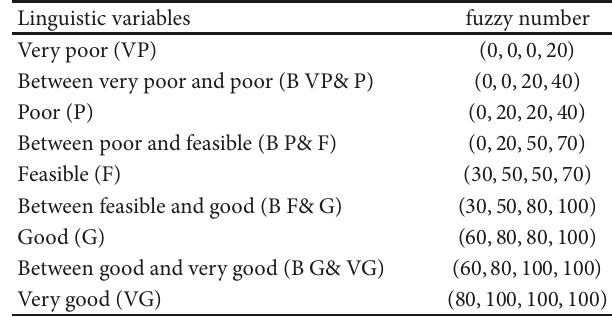
Table 1: Linguistic variables and fuzzy numbers for weights. Linguistic variables